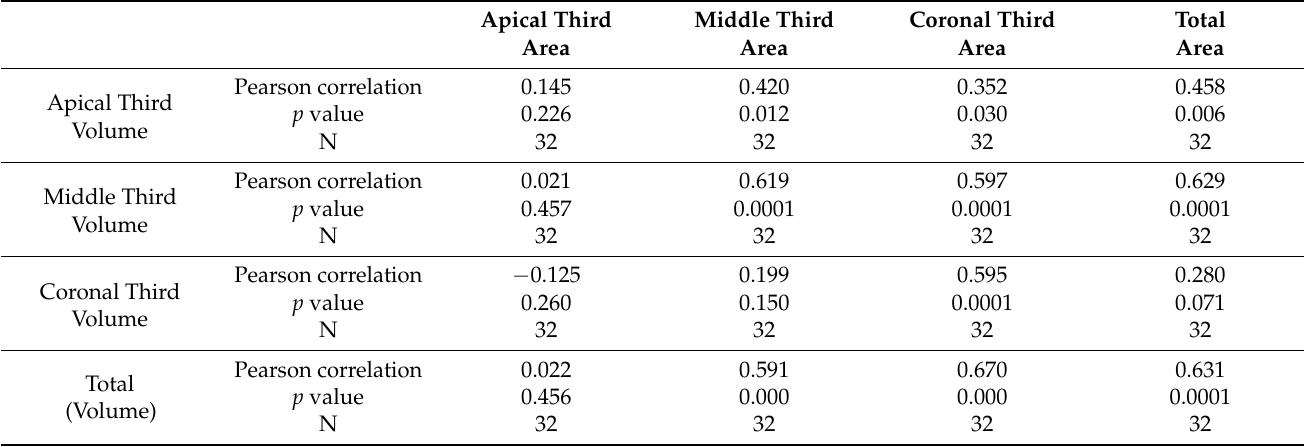
Table 5. Pearson correlation of areas and volumes of GF group ( p value was set at 0.05). Apical